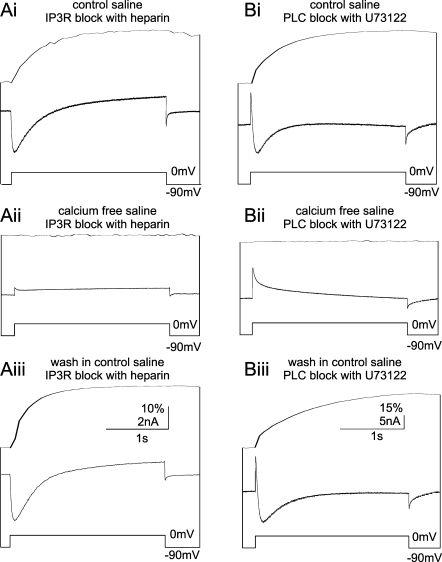
Voltage-Induced Intracellular Calcium Signals Depend on IP3R and PLC Activation(A) (i) In heparin-loaded (500 nM), acutely isolated DUM neurons in TEA- and TTX-containing saline, a voltage step from −90 mV to 0 mV causes a calcium inward and a calcium-activated potassium outward current accompanied by an intracellular calcium signal. (ii) Exposing the heparin-loaded cell for 3 min to zero-calcium saline causes a complete loss of all membrane currents and the calcium signal. (iii) Switching back to calcium-containing saline for 3 min restores the original currents and the calcium signal.(B) Same representative experiment as in (A), but the neuron is loaded with the PLC blocker U73122. Pharmacological block of IP3Rs and of PLC both abolish voltage-induced calcium signals in the absence of calcium inward current.